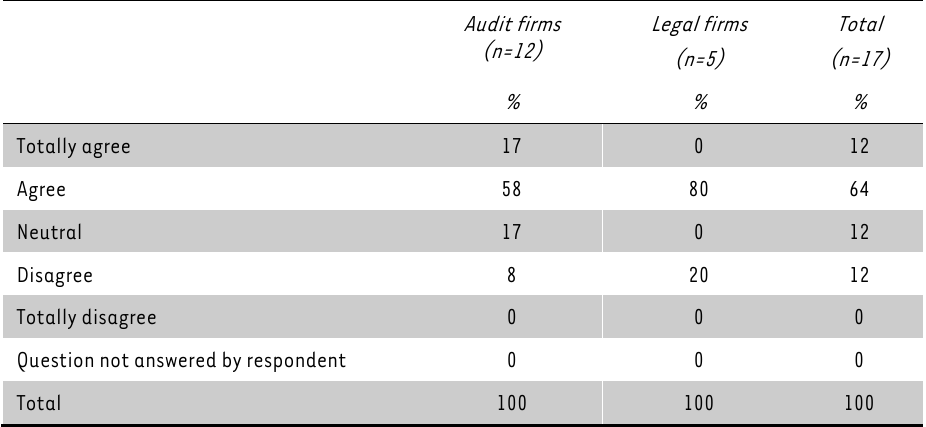
Results of Question 2